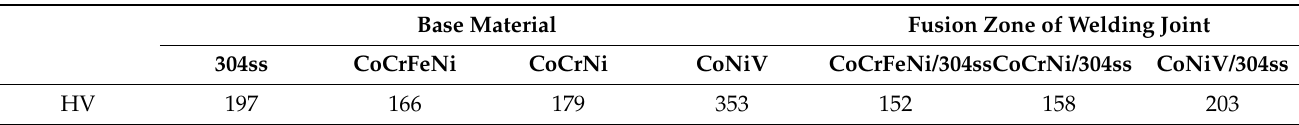
Table 2. Different welding base material and welded joint-hardness